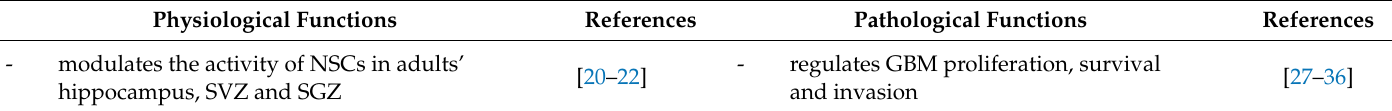
Table 1. The function of neurotransmitters in CNS and